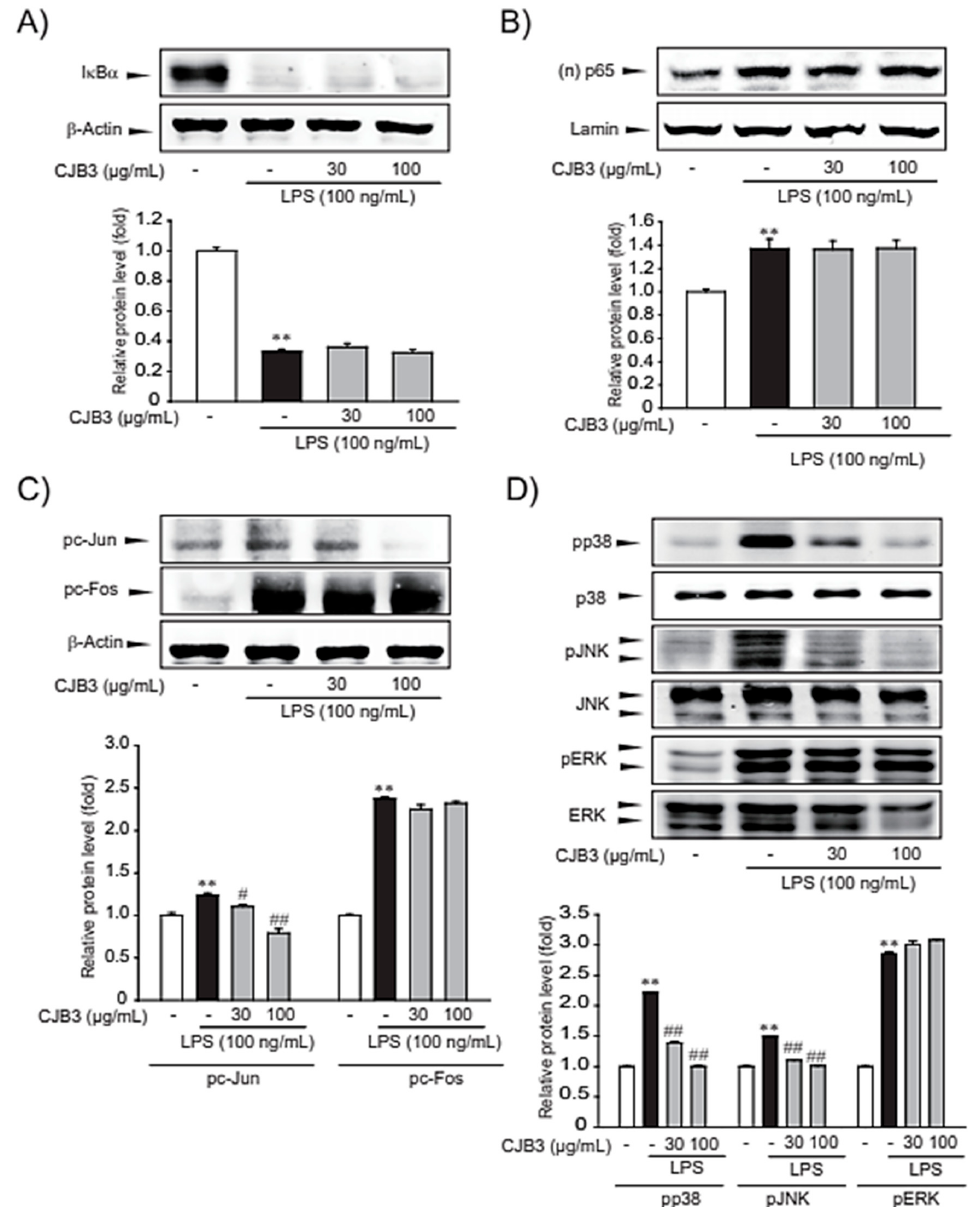
Figure 7. CJB3-induced specific inhibition of c-Jun, p38 and JNK phosphorylation in LPS-activated RAW264.7 cells. ( A ) Immunoblotting for total I κ B α : cells were pretreated with CJB3 for 1 h before LPS stimulation for 15 min. Total I κ B α in the cell lysate was immunoblotted. ( B ) The expression level of p65 protein in cells with nuclear fraction. Using Lamin as control for nuclear fraction. RAW264.7 cells were pretreated CJB3 for 1 h and then incubated with LPS for 3 h. ( C ) Immunoblotting for c-Jun and c-Fos phosphorylation: cells were pretreated with CJB3 for 1 h before LPS stimulation for 2 h, and cell lysates were immunoblotted to examine c-Jun and c-Fos phosphorylation. ( D ) Effect of CJB3 on LPS-induced phosphorylations of MAPKs: cells were treated with CJB3 for 1 h before LPS stimulation for 30 min. Data are expressed as the mean ± SE of three replicates; ** p < 0.01, significant vs. vehicle-treated control; # p < 0.05, ## p < 0.01, significant vs. LPS alone. Next, the effect of CJB3 on LPS-induced phosphorylation of mitogen-activated protein kinases (MAPKs) was assessed. In macrophages, MAPKs, including extracellular signal- regulated kinase (ERK), p38, and c-Jun N-terminal kinase (JNK), are crucial mediators of proinflammatory cytokine production. The assessment results revealed that CJB3 inhibited LPS-induced phosphorylation of p38 and JNK but not ERK (Figure 7D). Overall, the